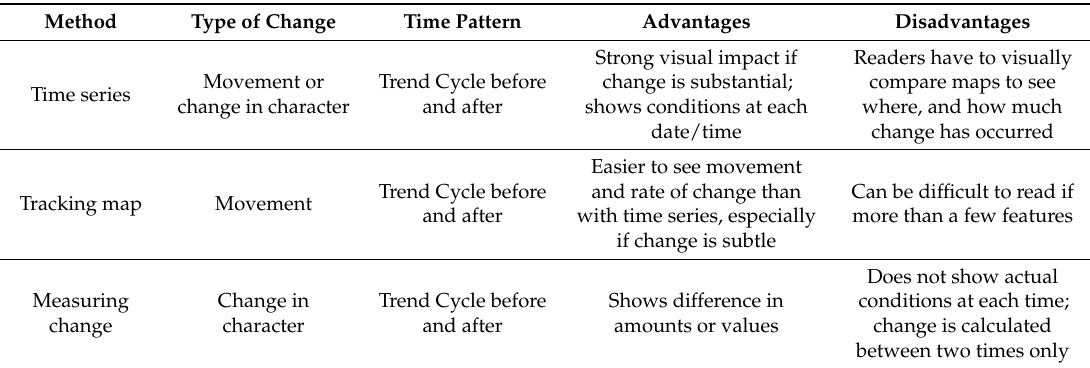
Table 2. Methods of comparing